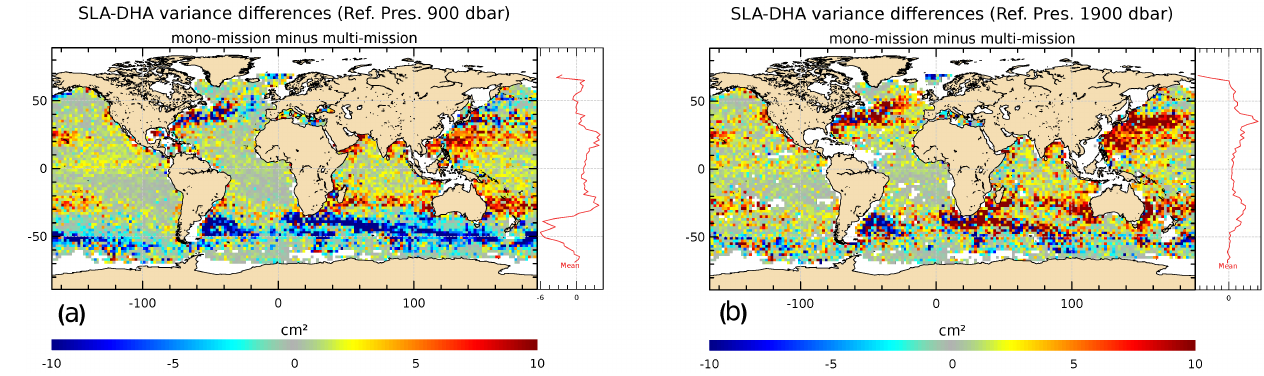
Figure 14. Map of the difference of variance of the altimeter SLA–Argo DHAs differences, using successively mono-mission and multi- missions grids of altimeter products with Argo 900dbar profiles (a) and 1900dbar profiles (b) .